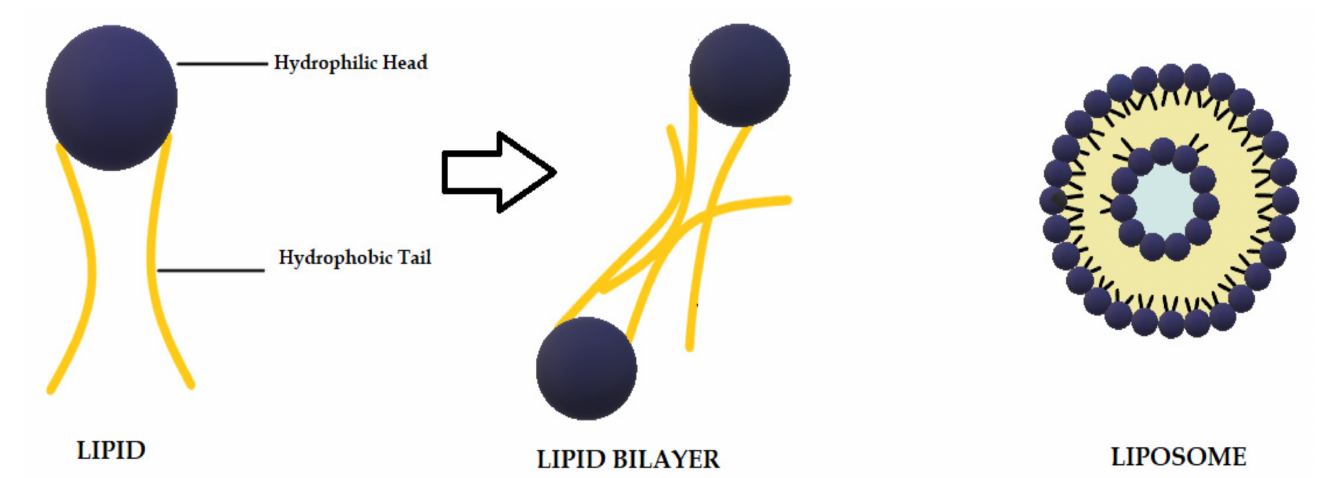
Figure 2. Schematic representation of the liposome structure. Table 3. Antimicrobial studies performed with CUR in liposomes and solid lipid nanoparticles (SLN). Type of [CUR] Microorganism Liposomes or SLN Formulation Lecithin and